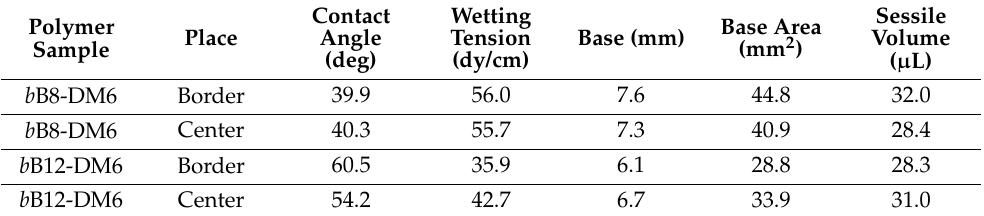
Figure 7. Contact angle measurements on b B12-DM6 ( upper row) and b B8-DM6 ( lower row) films: contact point close to the border ( left panels); contact point near the center of the specimen ( right panels). Table 9. Wettability of